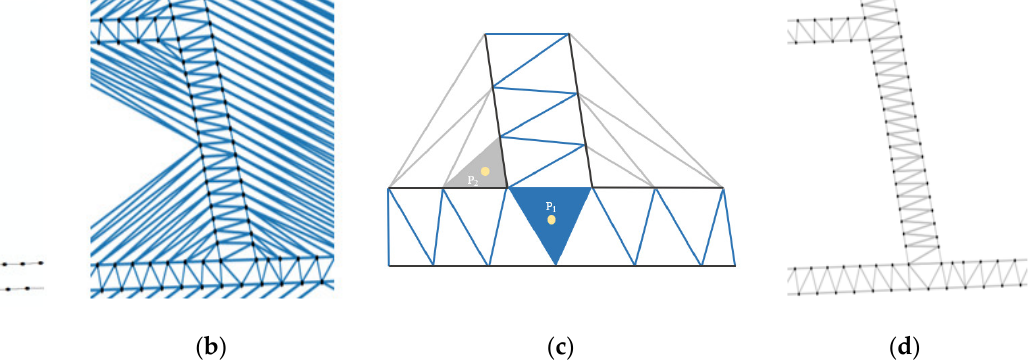
Figure 3. Illustration of the steps to construct a constrained Delaunay triangle. ( a ) Points densifica- tion; ( b ) Constructing Delaunay triangulation; ( c ) Determination of road triangles; ( d ) Constructing CDT.